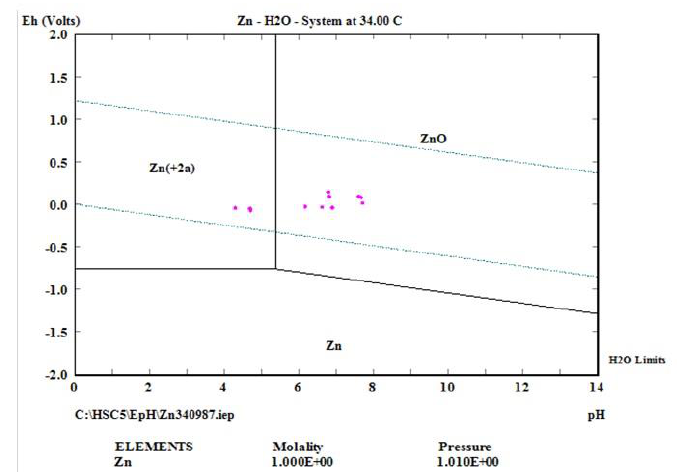
Fig. 6(a): Speciation of Zn in different Eh values in Tehran rainwater samples after the PEC process